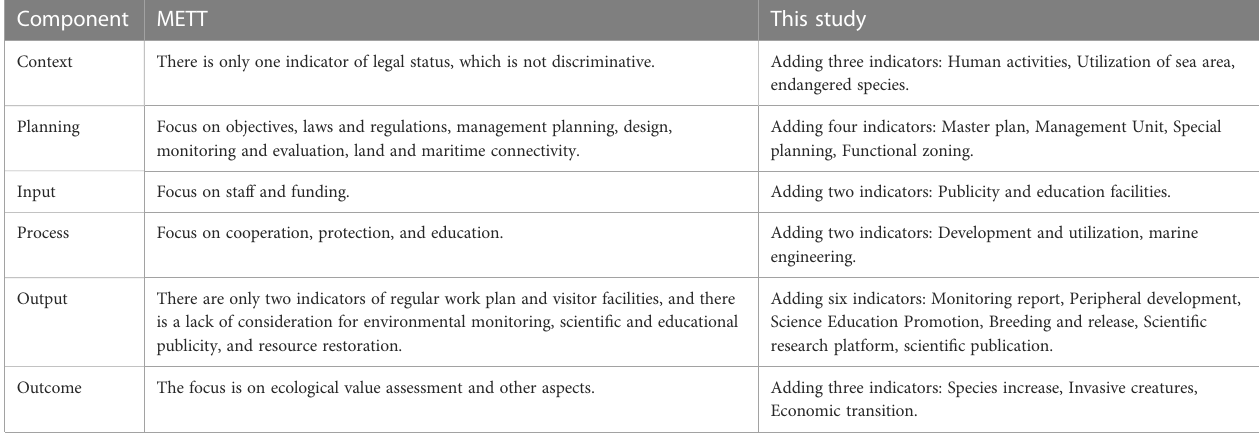
TABLE 2 Differences between two